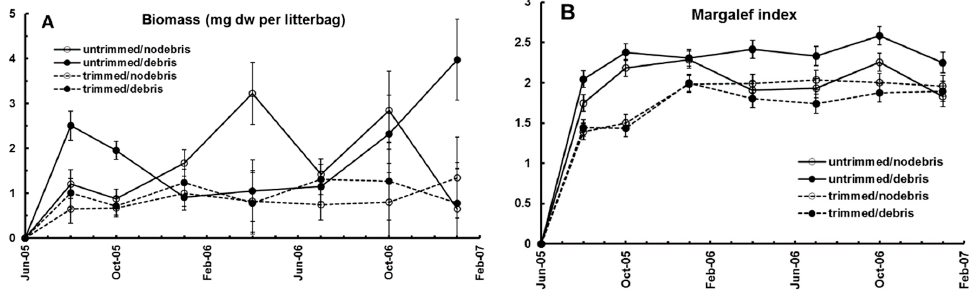
Figure 4. The effect of canopy trimming on biomass and diversity in litterbags. ( A ) Invertebrate biomass; ( B ) Margalef diversity index. See [19].